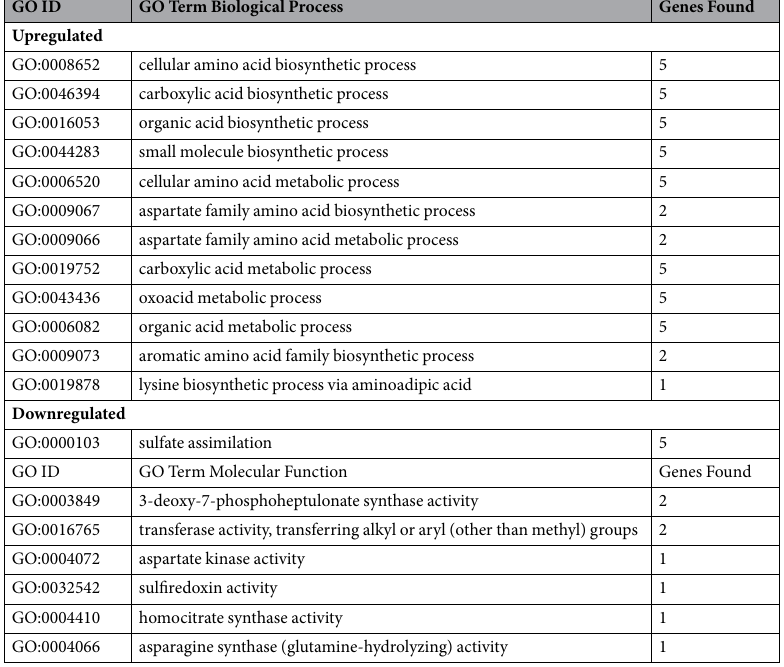
Table 3. List of the biological processes and molecular functions found to be differentially expressed (up and down regulated), according to Gene ontology (GO). KEGG ID Pathways Names Size Genes FDR